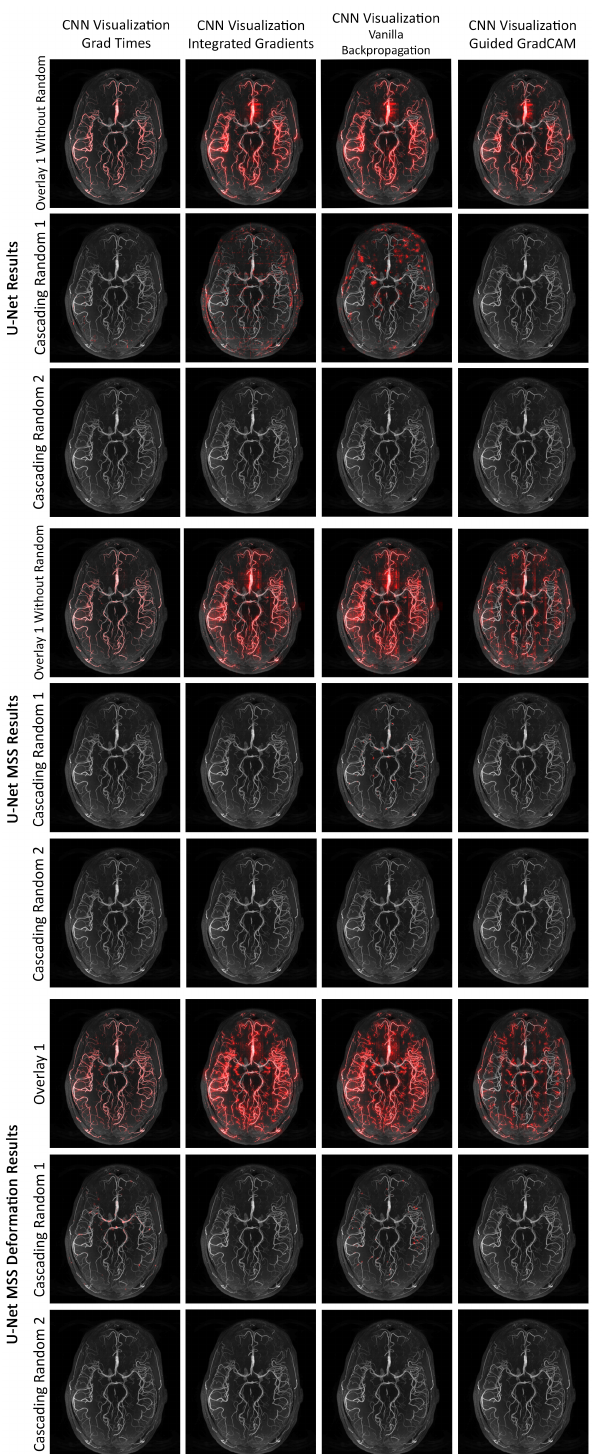
Figure 9. Example of cascading randomisation outputs of the three models: U-Net, U-Net MSS, and U-Net MSS with deformation. The outputs of all models and methods show the focus without randomisation fading through cascading randomisation 1 and 2. This implies that the output of these interpretability methods relies upon the weights of the network and not just random predictions. CNN Visualisation-Guided GradCAM shows the strongest dependency on the weights as even with cascading 1, all the attributions disappeared. Comparing the attributions for U-Net against the other two models, it can be observed that the dependency on weights is stronger for the other